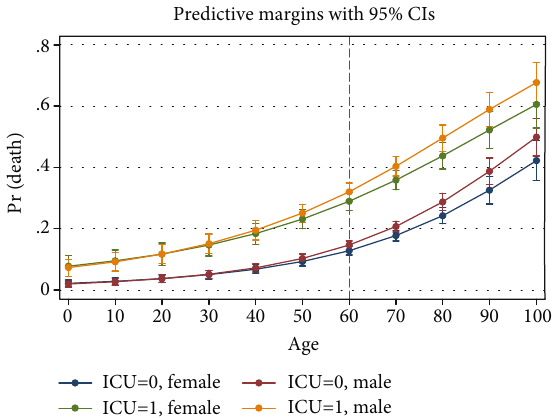
Figure 6: Association of gender with probability of death based on age and ICU admission (from logistic regression of Table 3, step